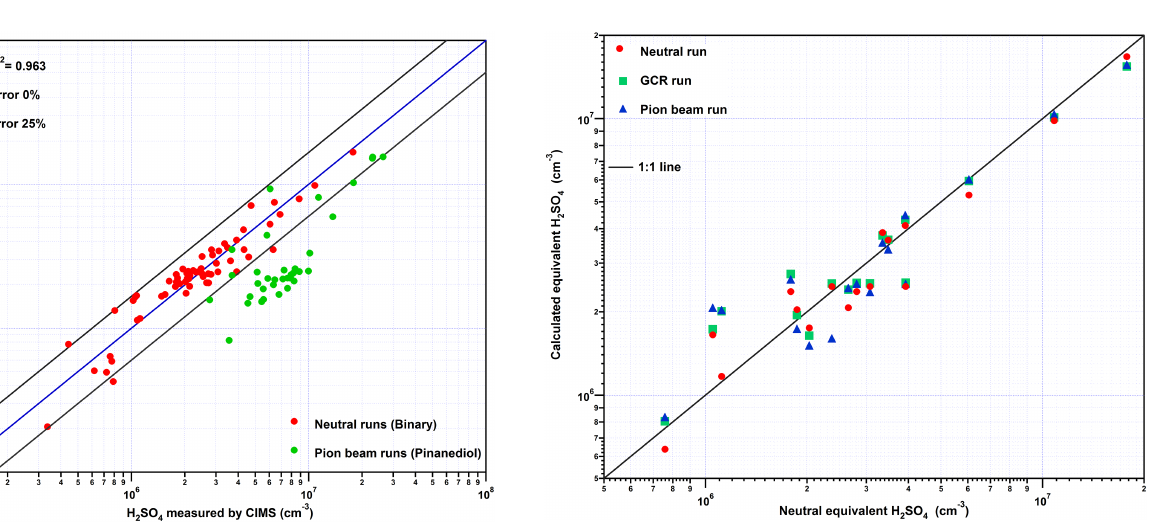
Figure 8. For some GCR (galactic cosmic ray) and pion beam runs a neutral run preceded where the conditions of the chamber were identical. This figure compares the parameterised [H 2 SO 4 ] for the GCR and beam runs to the value from the neutral stage. The good agreement indicates that the parameterisation can also be applied to the GCR and beam runs when no information on the [H 2 SO 4 ] under neutral conditions is